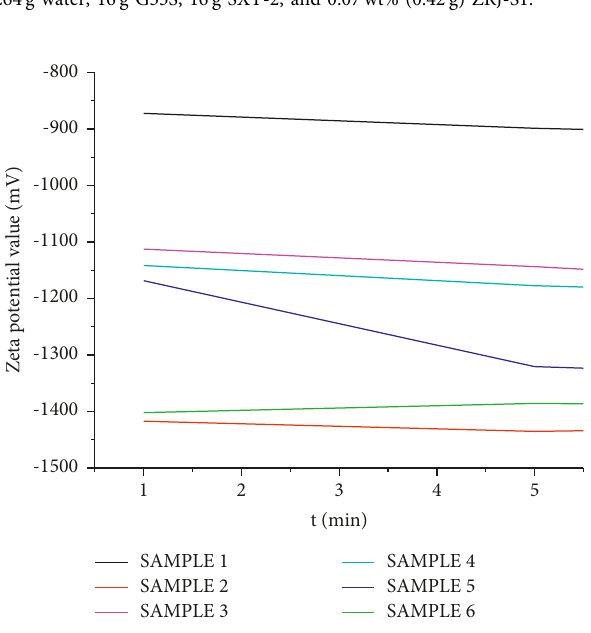
Figure 11: ZETA potential changes of ZRJ-S1 reinforced cement- based materials.